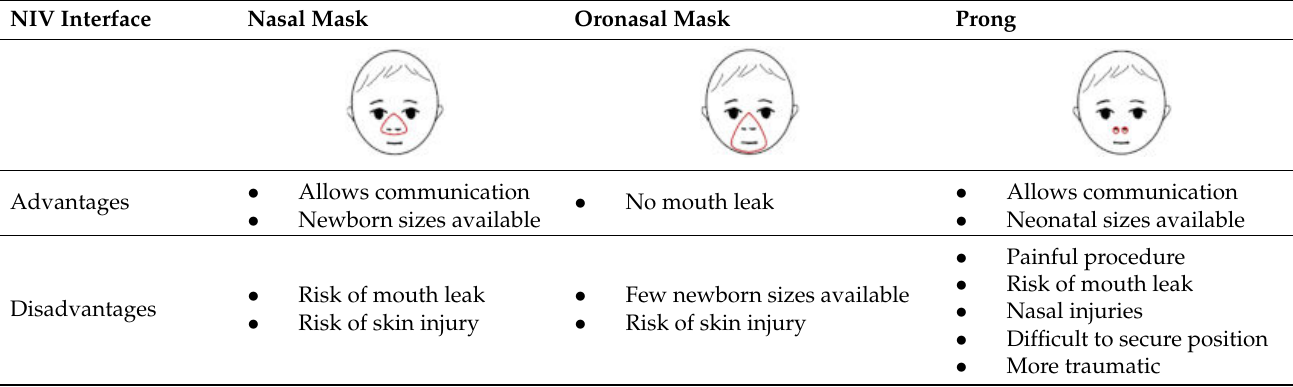
Table 1. Interfaces for non-invasive ventilation in pediatrics with advantages and disadvan- tages